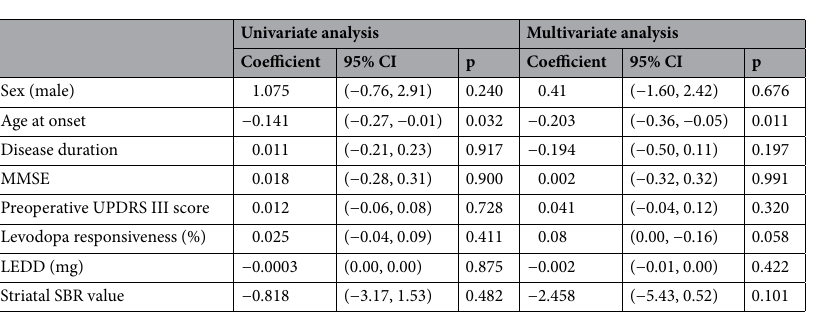
Table 4. Univariable and multivariate regression analysis of the factors associated with the changes in UPDRS IV scores 12 months after GPi DBS in patients with advanced Parkinson’ disease. DBS, deep brain stimulation; GPi, globus pallidus interna; MMSE, Mini-Mental State Examination; SBR, specific binding ratio; LEDD, levodopa equivalent daily dose; UPDRS, Unified Parkinson’s Disease Rating Scale.